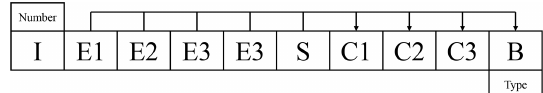
Figure 2. Data structure of expert experience and process